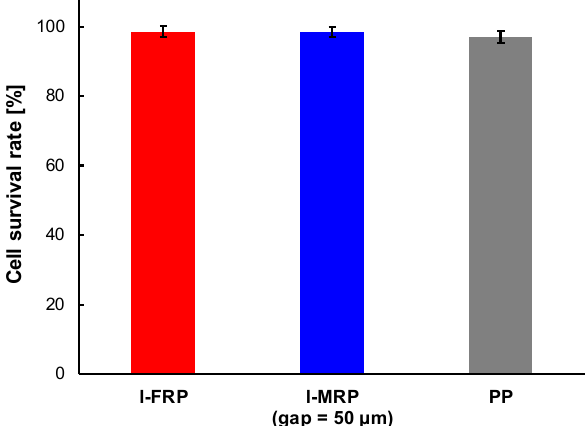
Figure 7. Survival rate of cells which were sent with the l-FRP and the l-MRP (gap = 50 µ m) and the PP. The survival rates were 99% ± 2% (l-FRP), 98% ± 2% (l-MRP; gap = 50 µ m) and 97% ± 2% (PP). The experiment was carried out two times for each pump.